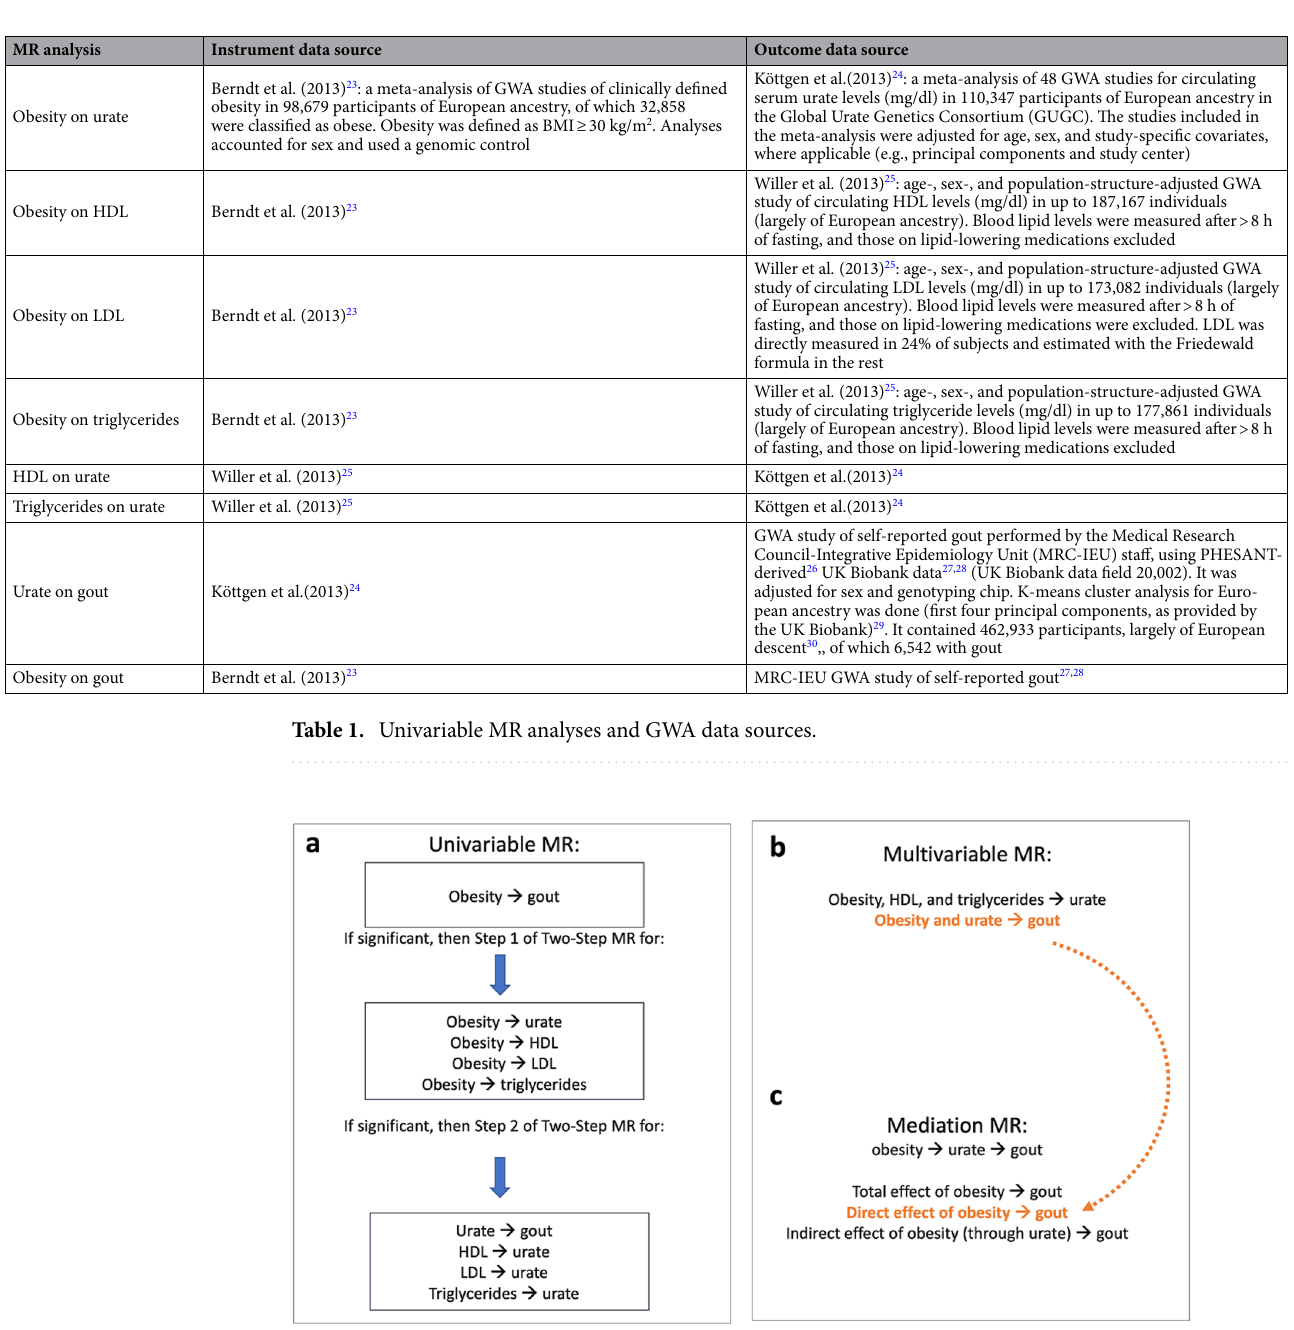
Figure 1. Overview of MR approaches used in the present study: univariable, two-step, multivariable, and mediation MR. ( a ) Flowchart of possible univariable and two-step MR models showing that only significant models from the Step 1 of two-Step MR are taken forward for Step 2 of two-step MR. ( b ) List of multivariable MR models. “Obesity and urate gout” was performed to obtain the direct effect of obesity on gout when accounting for urate and was used in the mediation analysis, as indicated by the orange coloring and arrow. ( c ) Mediation MR of obesity on gout with urate as the